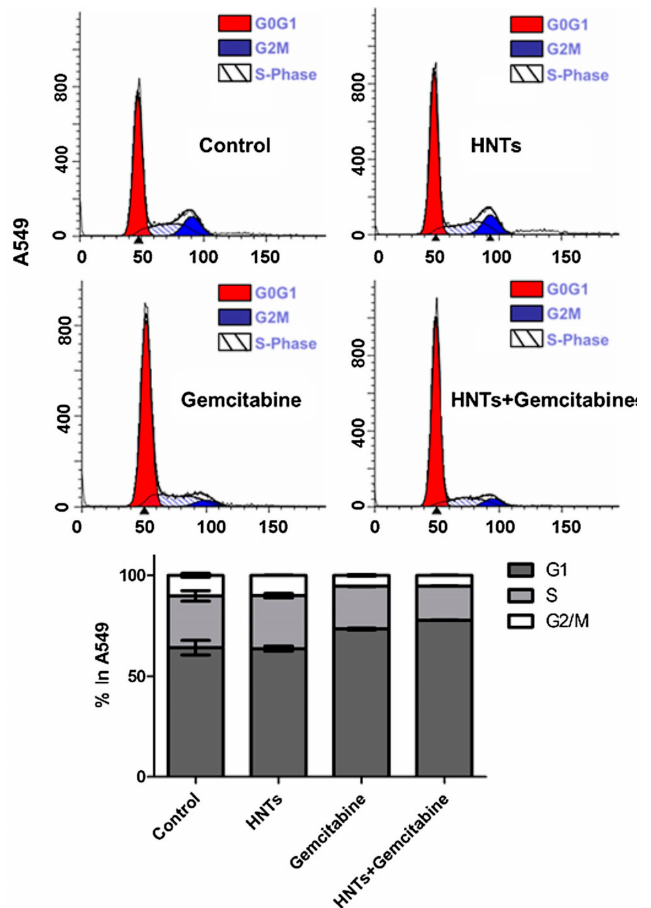
Figure 3. Study of A549 cell cycle after 24 h treatment with HNTs (0.1 µM), gemcitabine (0.1 µM) and HNTs + gemcitabine (0.1 µM). A549 cells were stained with propidium iodide. The red area shows G1 phase, the white area shows S phase, and the blue area shows G2/M phase. Bar diagram shows the % of cells present in different phases of cell cycle. Adapted from [105].